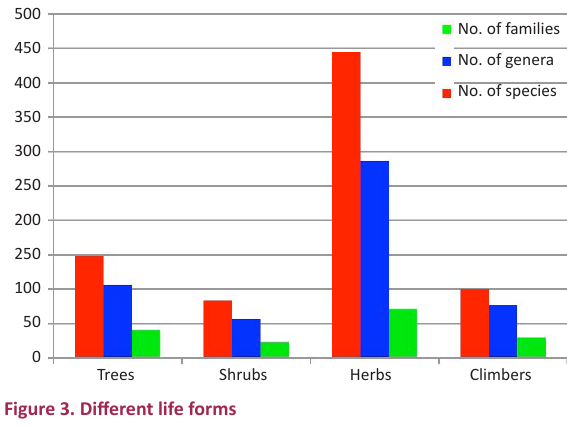
Figure 3. Different life